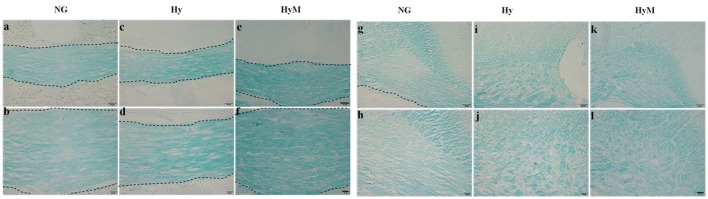
LFB staining for detection of white matter changes 60 days after hypoxia. The representative images of LFB staining in corpus callosum (a–f) and in cingulum (g–l) in indicated groups. Scale bar = 50 μm in the top and scale bar = 20 μm for the bottom. NG represents normal control rats, Hy represents hypoxia rats, Hy M represents hypoxia rats with minocycline treatment.